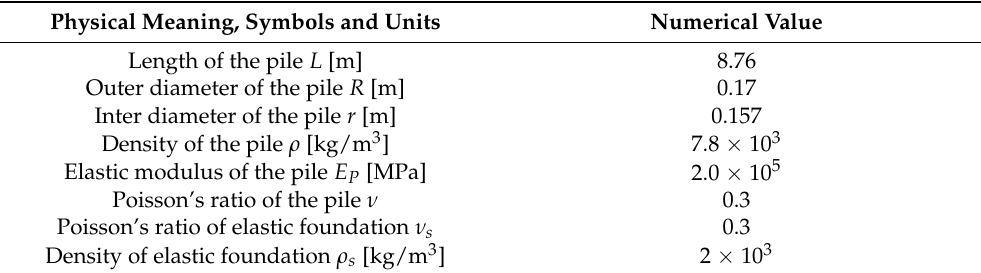
Table 1. Physical parameters of the single pile and foundation during the